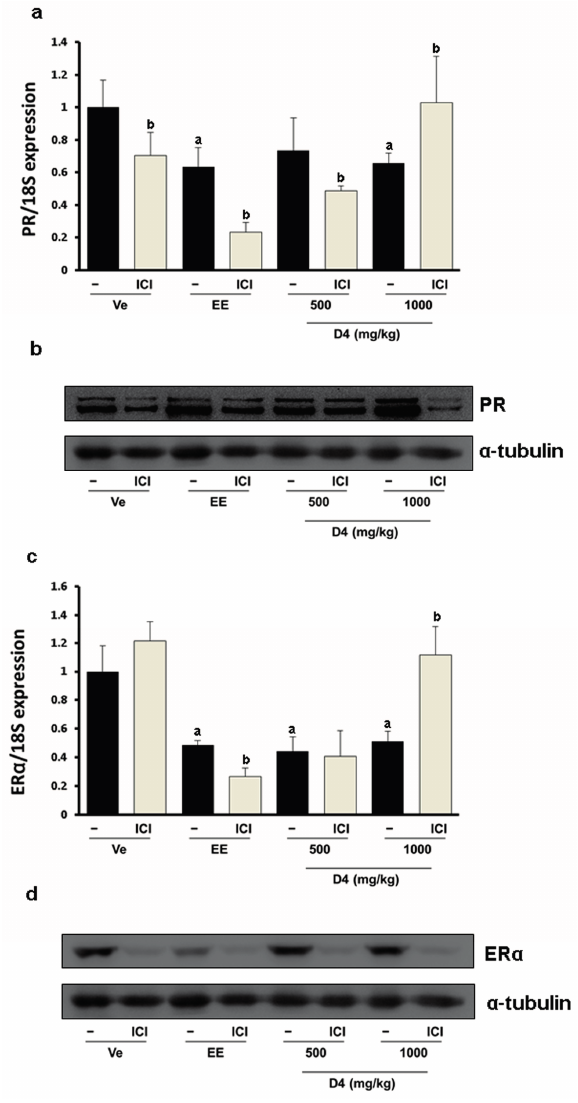
Figure 6. PR expression at the mRNA ( a ); and protein ( b ); levels in immature female SD rats. ER α expression in immature female SD rats at the mRNA ( c ); and protein ( d ) levels. Findings presented in the bar graph are divided according to chemical administered and subdivided according to the presence or absence of ICI 182 780 (shown as ICI). a p < 0.05 versus vehicle, b p < 0.05 versus without ICI. Data are presented as the mean ±